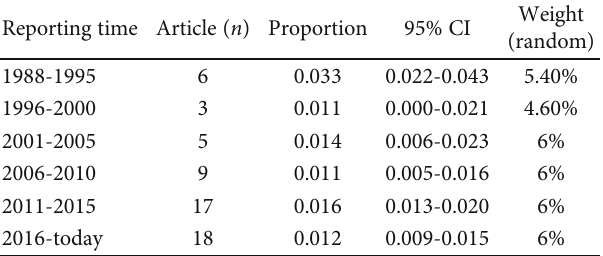
Table 8: The literature reporting time in CRC risk in UC